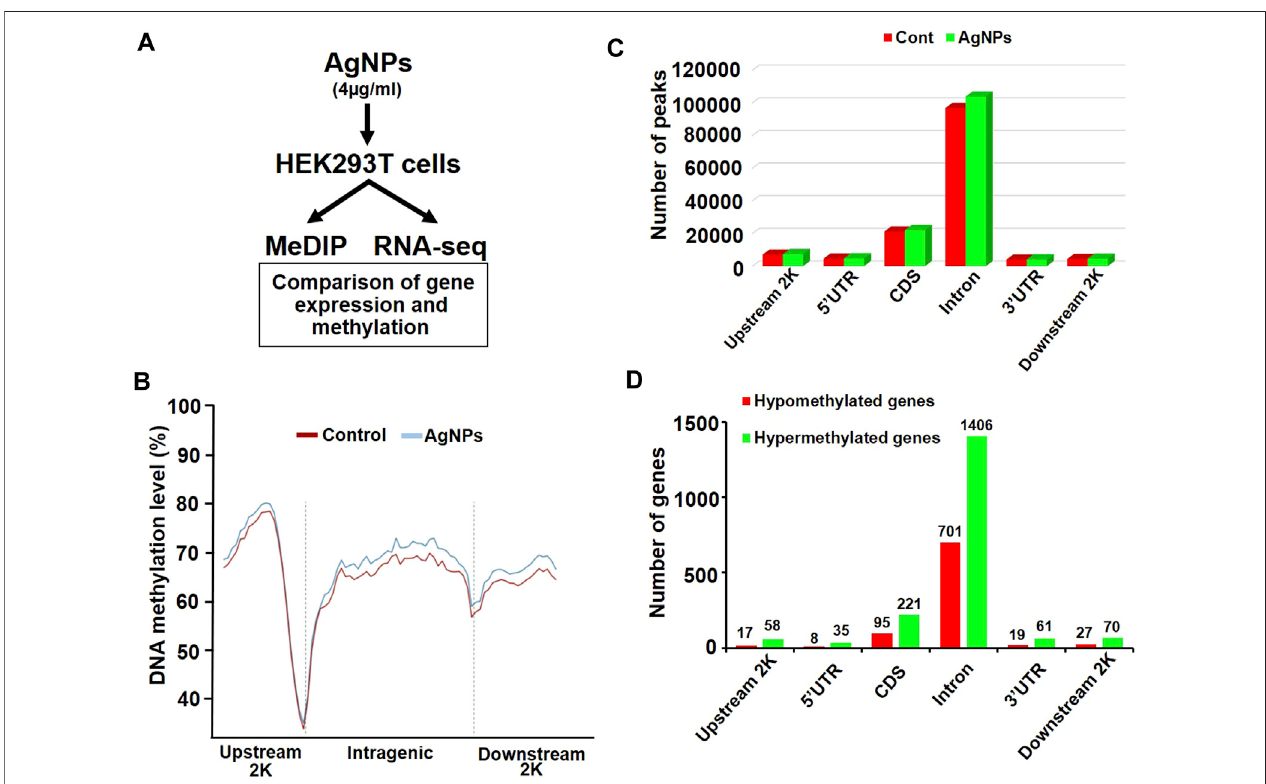
FIGURE 3 | The changes of DNA methylation in different genomic regions in HEK293T cells after AgNPs exposure. (A) Simple experimental fl ow diagram for the sequencingofgenemethylationandexpressioninHEK293Tcellsexposedto4 μ g/mlAgNPs. (B) RelativeDNAmethylationlevelsinHEK293TcellstreatedwithAgNPs. (C) Distribution ofDNAmethylationpeaks indifferentgenomicregionsafterAgNPsexposureinHEK293T cells. (D) Distributionofhypermethylated andhypomethylated genes in different genomic regions in HEK293T cells treated with AgNPs.